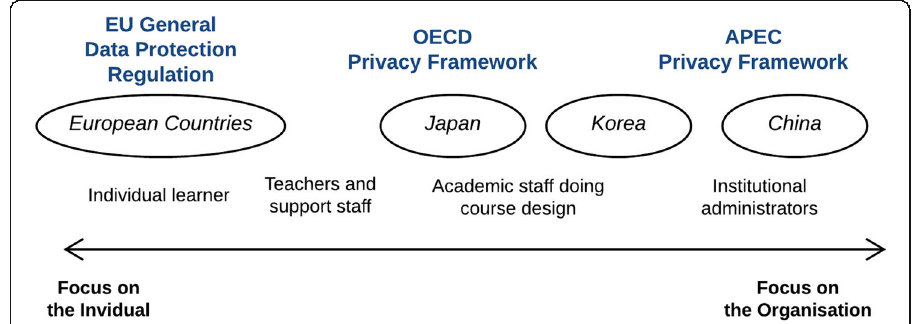
Fig. 1 Individual vs. organisational focus of LA beneficiaries, privacy frameworks and